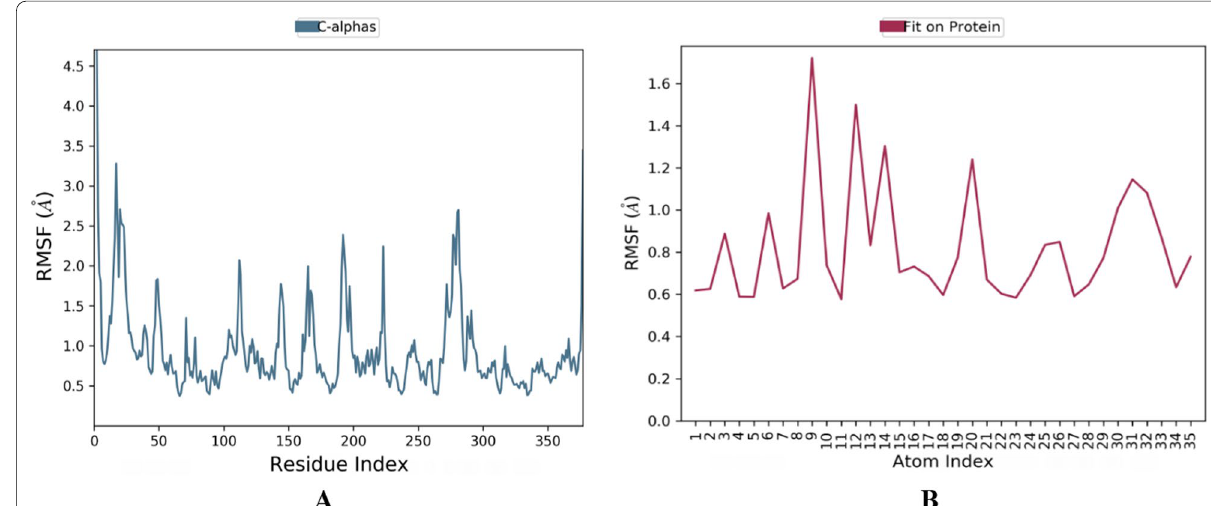
Fig. 5 Root-mean-square fluctuations (RMSF) plot for A protein B ligand